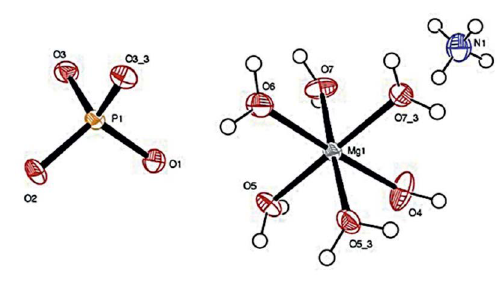
Fig. 5. Atomic coordination of struvite produced by E. aestuarii St. SR